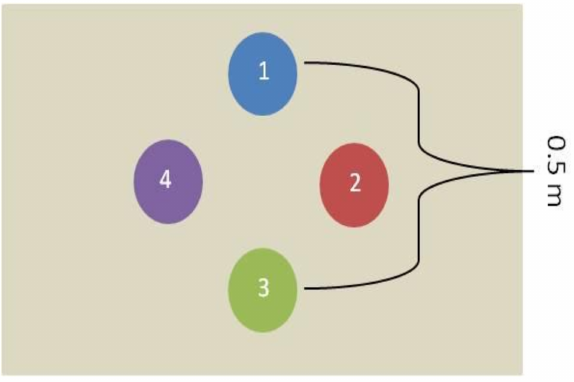
Figure 3. Bank pin installation diagram. Four bank pins were installed horizontally into the stream bank in a diamond pattern at each site. The length of the exposed pin was used to calculate